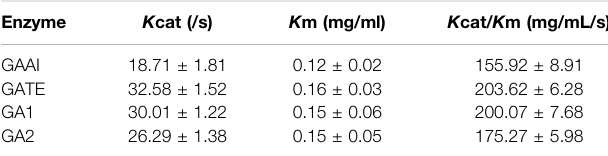
TABLE 2 | Kinetic parameters of recombinant